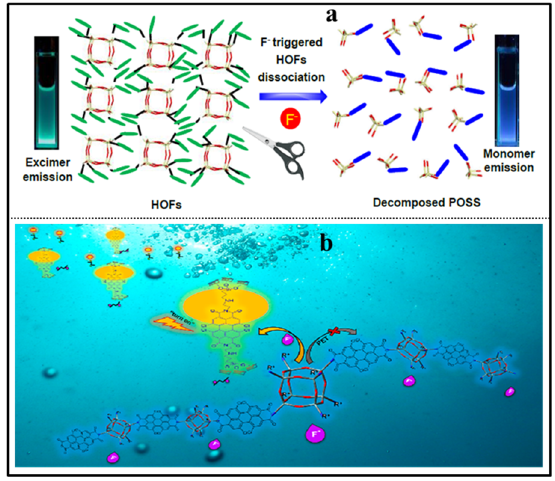
Figure 20. ( a ) Schematic illustration of POSS-based HOFs for the F¯ sensing [100]. ( b ) The possible mechanism of detecting F¯ by AE-PDI [101].